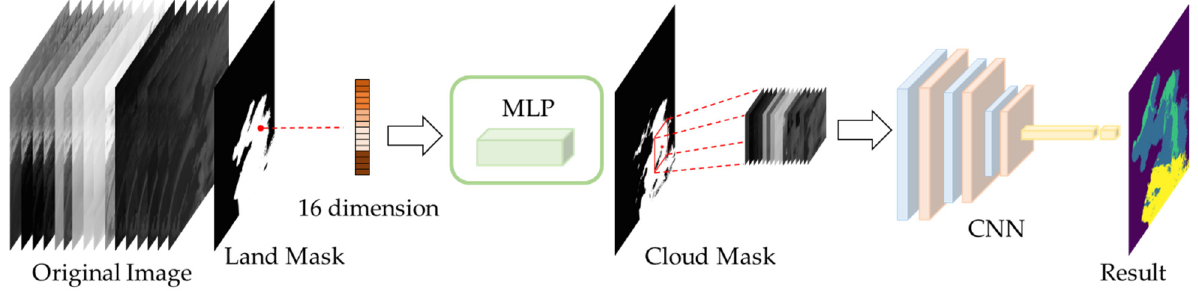
Figure 3. Flow chart of the proposed two-stage fog detection algorithm. Overall, it contained a fully connected MLP and a convolutional neural network. The sea fog, clear sky, cloud pixels are indi- cated in green, blue and yellow, respectively in the